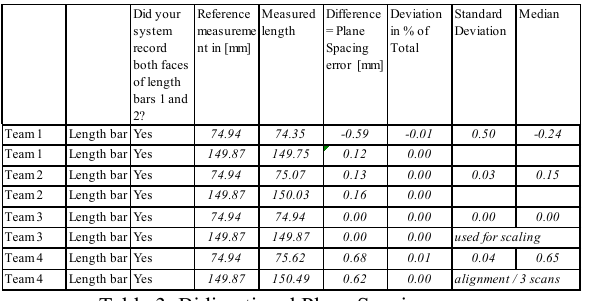
Table 3. Bidirectional Plane Spacing error.